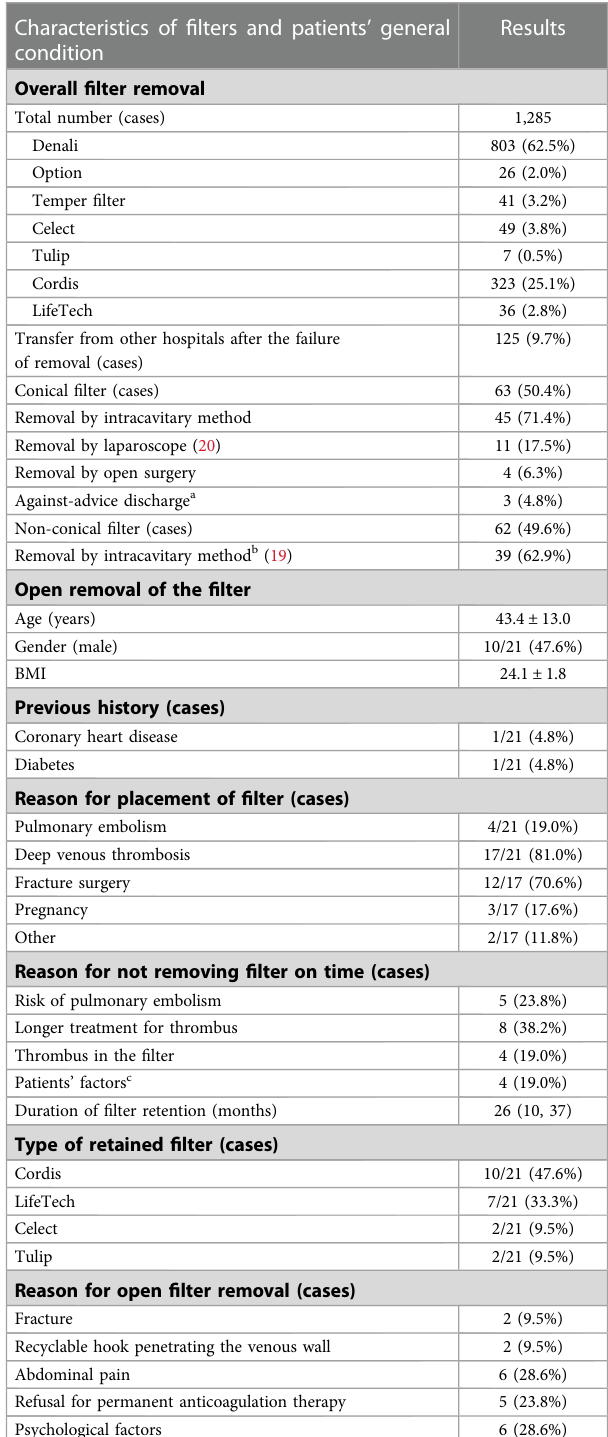
TABLE 1 Characteristics of fi lters and patients ’ general